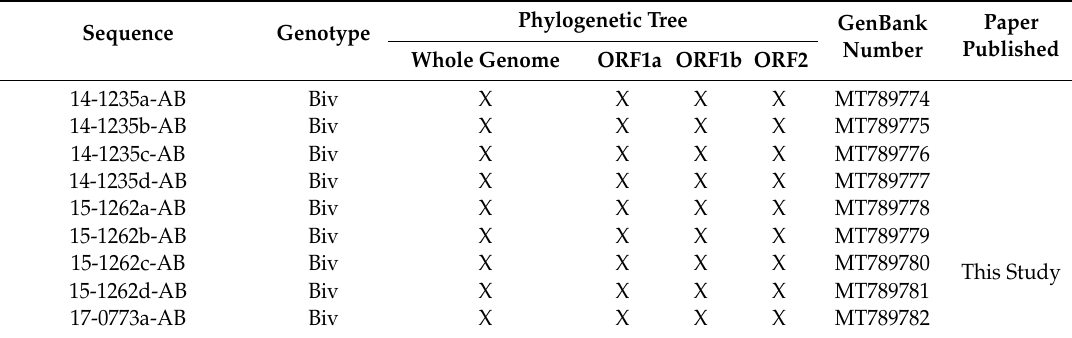
Table 2. List of all CAstV sequences in the study with GenBank Accession